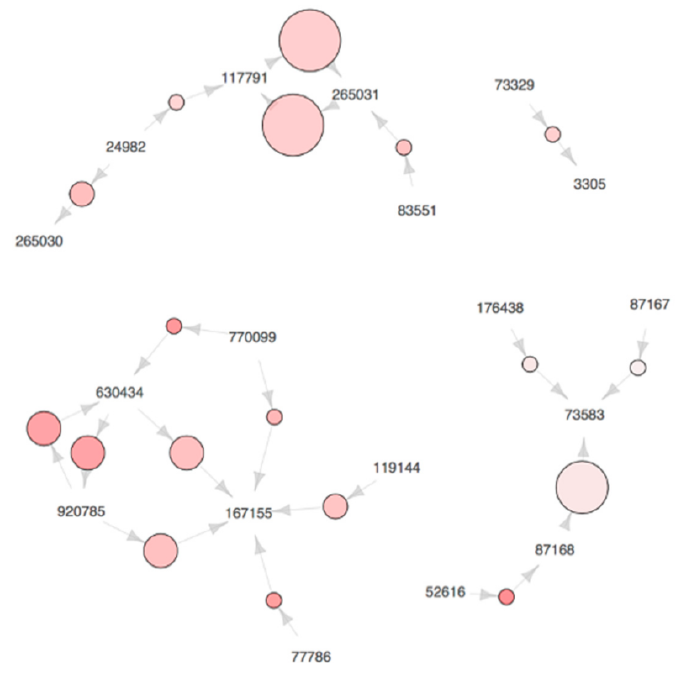
Figure 4. Association rule visualization for Scenario 1 Class 1-3. Note that the numbers indicate SKUs, size of circle indicates level of support (0.20–0.33) and color indicates level of lift (1.36–3.00).